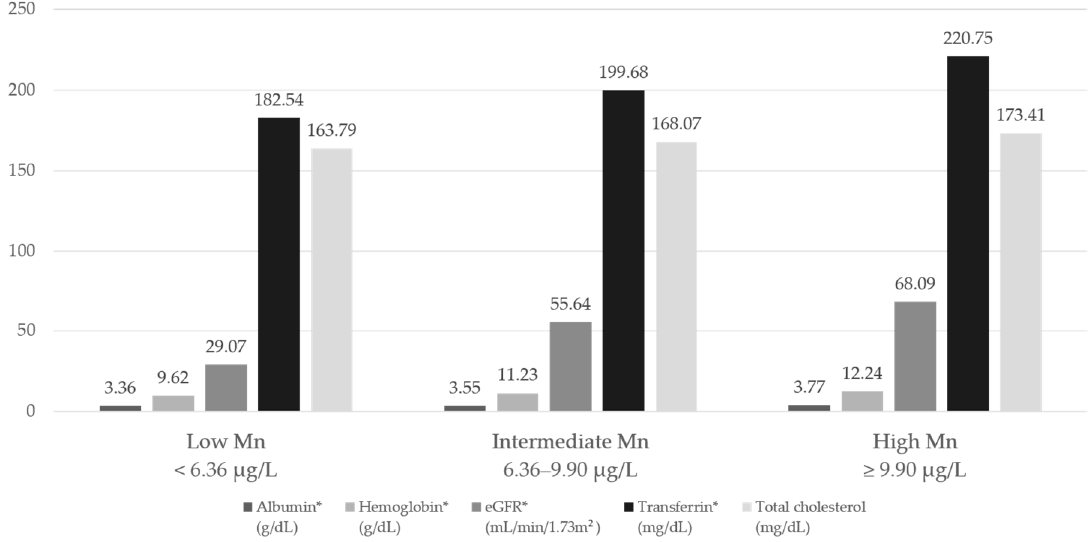
Figure 2. Nutritional markers according to blood Mn groups, * p < 0.05. Abbreviations: eGFR: estimated glomerular filtration rate